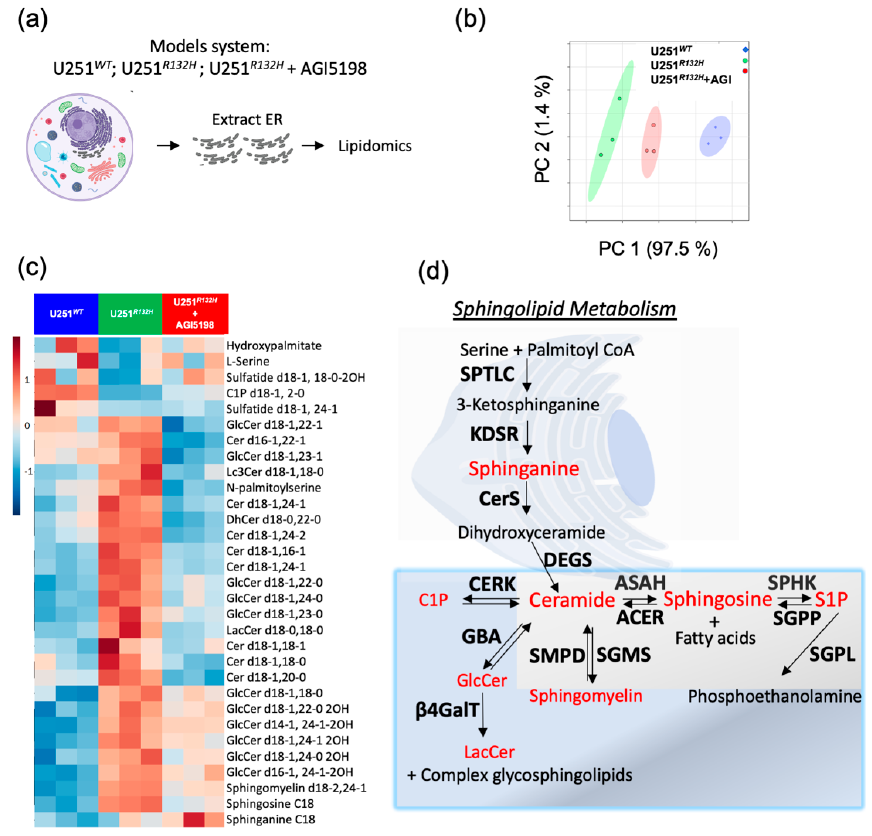
Figure 2. Sphingolipids pathway is upregulated in the endoplasmic reticulum of U251 cells overexpressing mutant IDH1-R132H variant and it is downregulated in response to suppression of D-2HG formation in this model cell line. ( a ) Schematic representation of the experiment set-up. ER were extracted from cells followed by lipids extraction. LC/MS was run to identify the lipidomic profile. ( b ) PCA analysis of lipids extracted from ER show clear separation between U251 WT (blue); U251 R132H (green) and U251 R132H +AGI5198 (red). ( c ) heatmap depicting relative levels of sphingosine, sphinganine, ceramides and downstream ceramide products from U251 WT (blue, n = 3); U251 R132H (green, n = 3) and U251 R132H + 12.5 µM AGI5198 (red, n = 3). ( d ) Schematic representation of sphingolipid pathway highlighting in red the species that are detected in all lipidomic experiments performed. Enzymes are shown in bold and the name of the pathway is underlined. Only ER data are shown since it is the location for the onset of sphingolipid biosynthesis. Serine palmitoyltransferase long chain (SPTLC), 3-ketodihydrosphingosine reductase (KDSR), ceramide synthase (CerS) and dihydroceramide desaturase (DEGS) are enzymes involved in the biosynthesis pathway. Neutral ceramidase (ASAH), alkaline ceramidases (ACER), sphingosine 1-phosphate kinase (SPHK), sphingosine 1-phosphate phosphatase (SGPP) and sphingosine 1-phosphate lyase (SGPL) are part of sphingolipid degradation. Sphingomyelin synthase (SGMS) and neutral sphingomyelinase (SMPD) show the connection between ceramide and sphingomyelin. Ceramide kinase (CERK) is found in the endosome, Golgi and mitochondria; beta-glucocerebrosidase (GBA) and β -1, 4-Galactosyltransferase ( β 4GalT) are